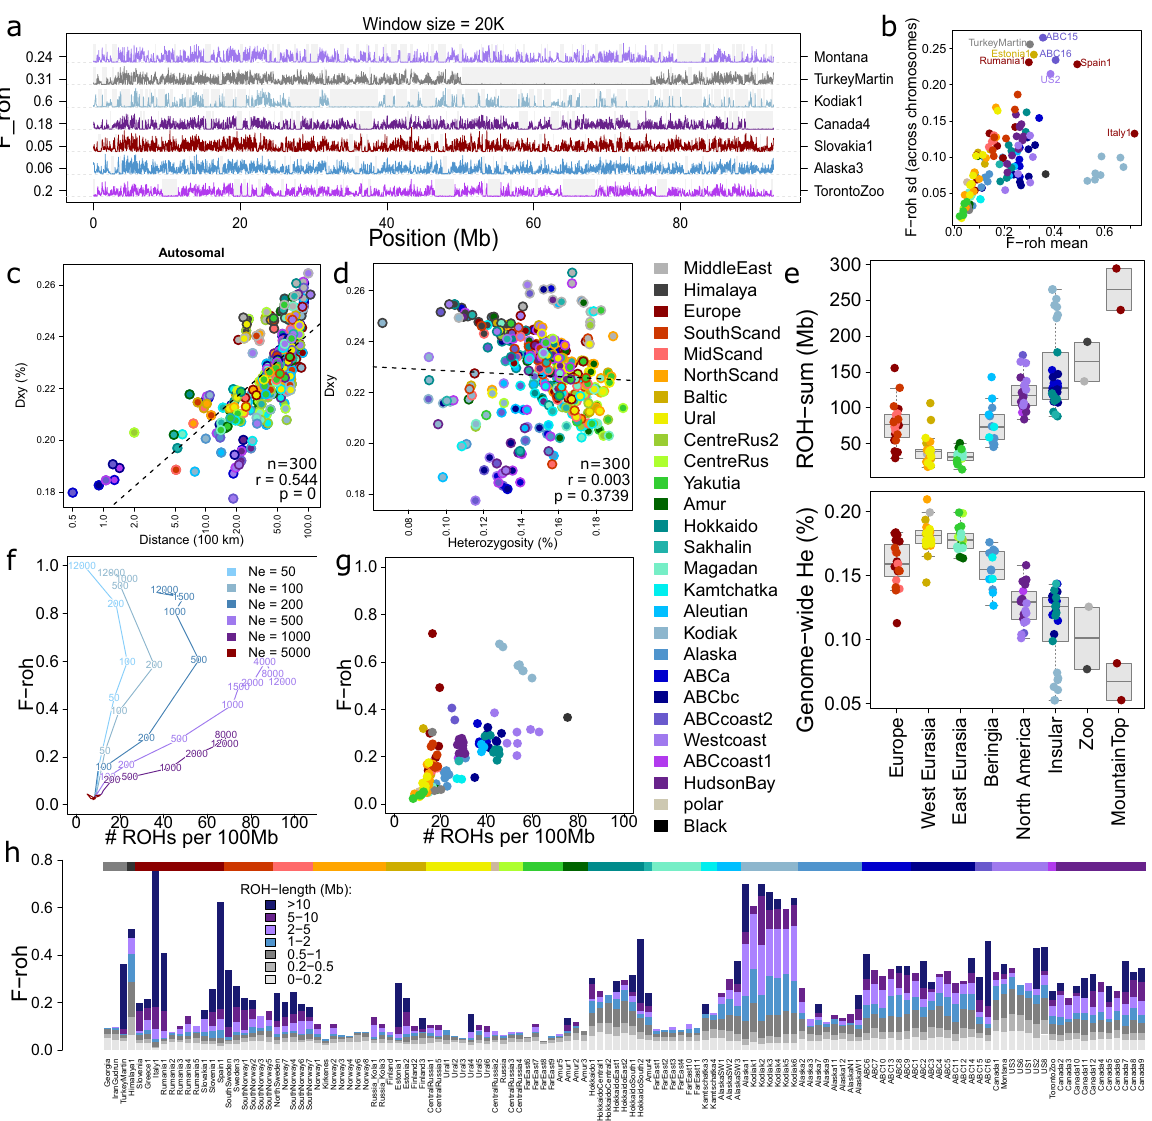
Fig. 6 Heterozygosity analyses reveal recent inbreeding on isolated mountain-tops, and ancient population bottlenecks in Kodiak and grizzly bears. a Variation of heterozygosity levels ( He ) across a randomly chosen chromosome, for a random subset of samples, depicting He-levels of non-overlapping 20 kb windows, with grey segments highlighting the genomic regions which are marked as run of homozygosity (ROH) by the newly developed ROH-detection software Darwindow. Values along the y-axis represent sample and chromosome-speci fi c F ROH -values (proportion of chromosome marked as ROH). b Standard deviation of sample-speci fi c F ROH -values across chromosomes versus genome-wide mean F ROH -values. High standard deviations are indicative of recent inbreeding events. c Mantel plot showing, for all (25 ∙ 24/2 = ) 300 brown bear population pairs, mean genome-wide genetic distance (D XY ) versus geographic distance. d D XY -values against mean genome wide He-estimates, for all possible 300 population pairs. Population pairs involving bears from Middle East and North America affect the signi fi cance of the linear regression model. e Boxplots depicting sample-speci fi c ROH-length and genome-wide He estimates, with samples grouped according to sample origin. Centre lines indicate median, and box limits indicate upper and lower quartiles. f SLIM2 genetic forward-in-time simulations indicate that following a population size reduction (from an initial Ne of 5000 individuals), and given suf fi cient time, ROH-distributions converge to a new equilibrium, with the relationship between F ROH and number of ROHs depending on the new Ne . Shown are the number of generations since the population size reduction. g , h Sample speci fi c ROH-distributions. The colour bar above the stacked barplot indicates population